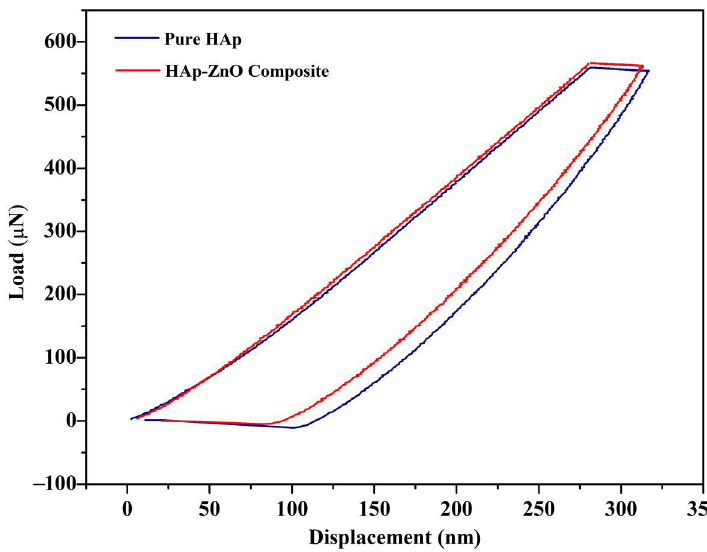
Figure 5. Force–displacement curves of HAp and HAp-ZnO composite.